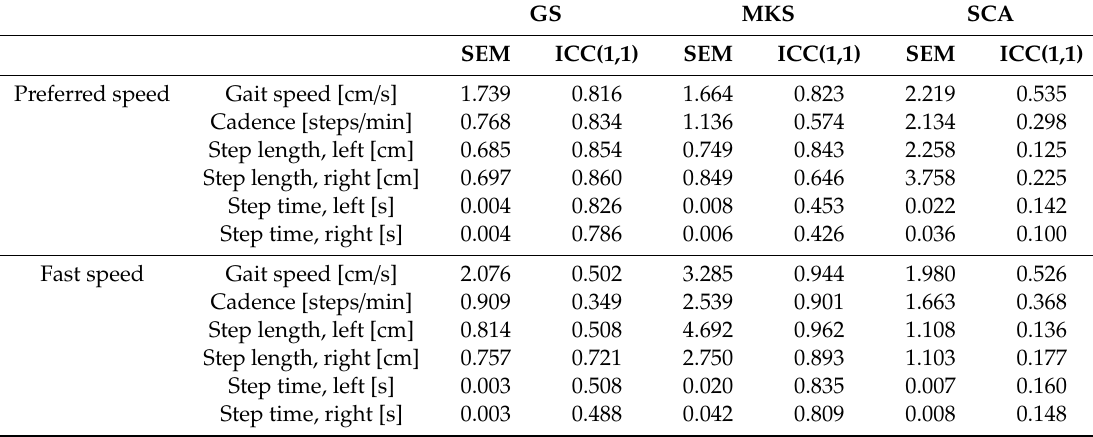
Table 3. ICC(1,1) Intratrial repeatability for GS, MKS, and SCA at preferred and fast